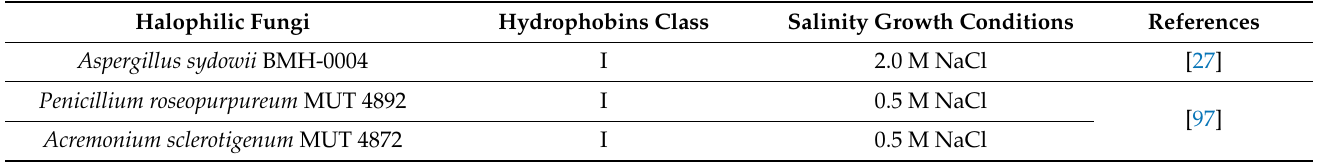
Table 3. Halophilic fungi as a source of